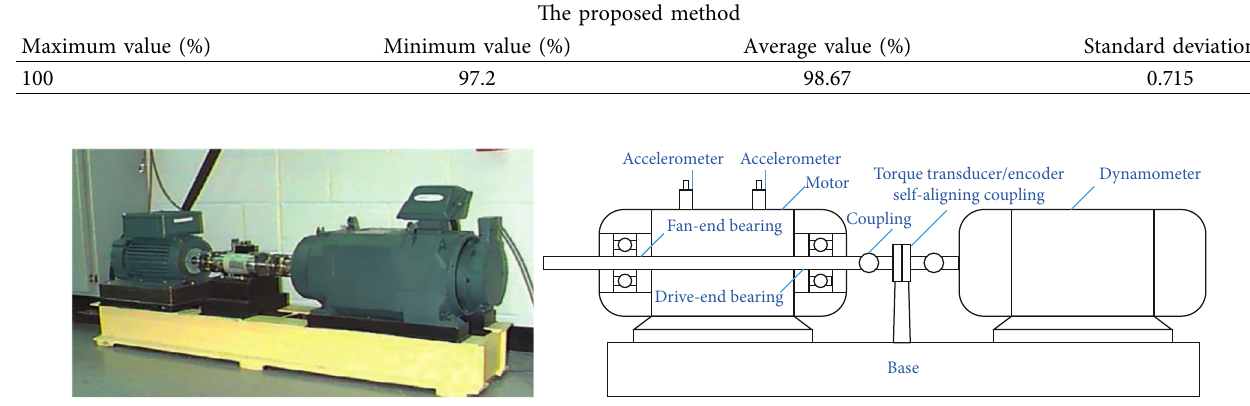
Figure 10: The appearance and structure abridged drawing of the bearing test bench. Table 3: The brief information of the bearings’ ten working conditions